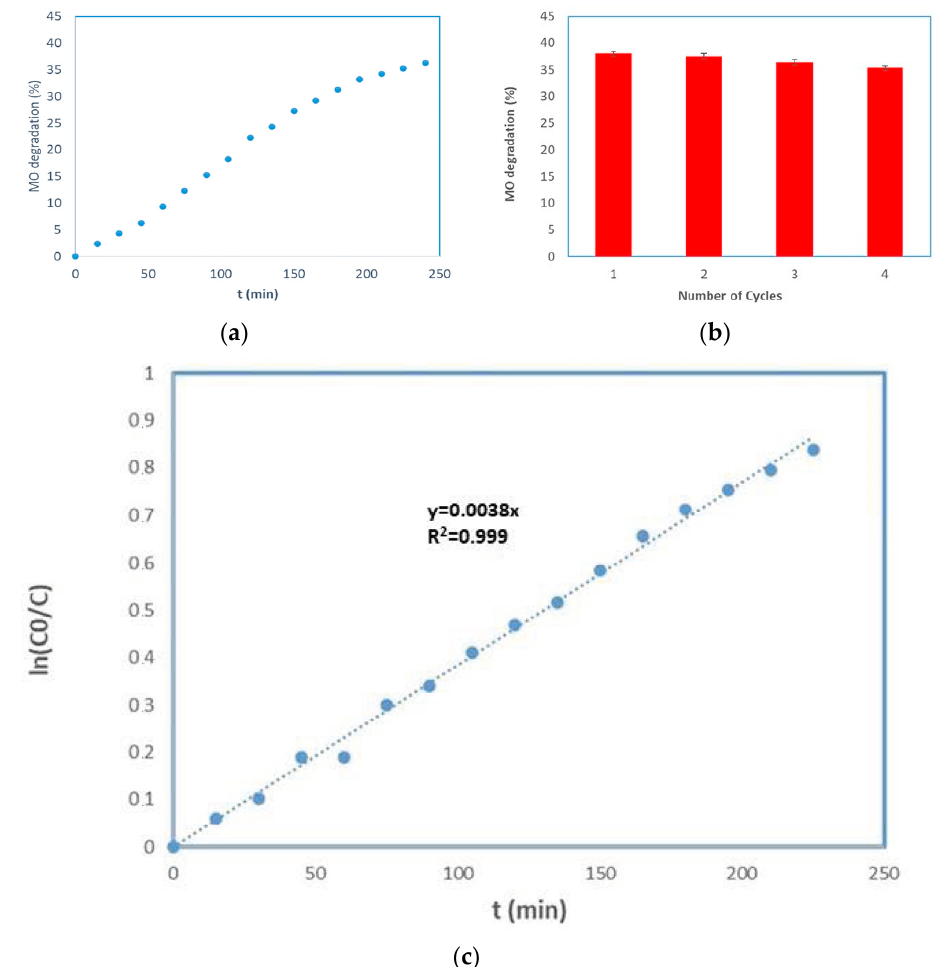
Figure 7. MO degradation by using the TiO 2 –Al 2 O 3 membranes: ( a ) MO degradation versus time. ( b ) Reusability of the TiO 2 –Al 2 O 3 membrane. ( b ) MO degradation after four successive reactions. Kinetics of methyl orange photodegradation: ( c ) ln(C 0 /C) versus time for the MO degradation. Operating conditions: C 0 = 1 mgL − 1 ; Volume of MO solution = 1 L; Stirring rate = 3 rpm; T = 25 °C; UV energy = 365 nm.